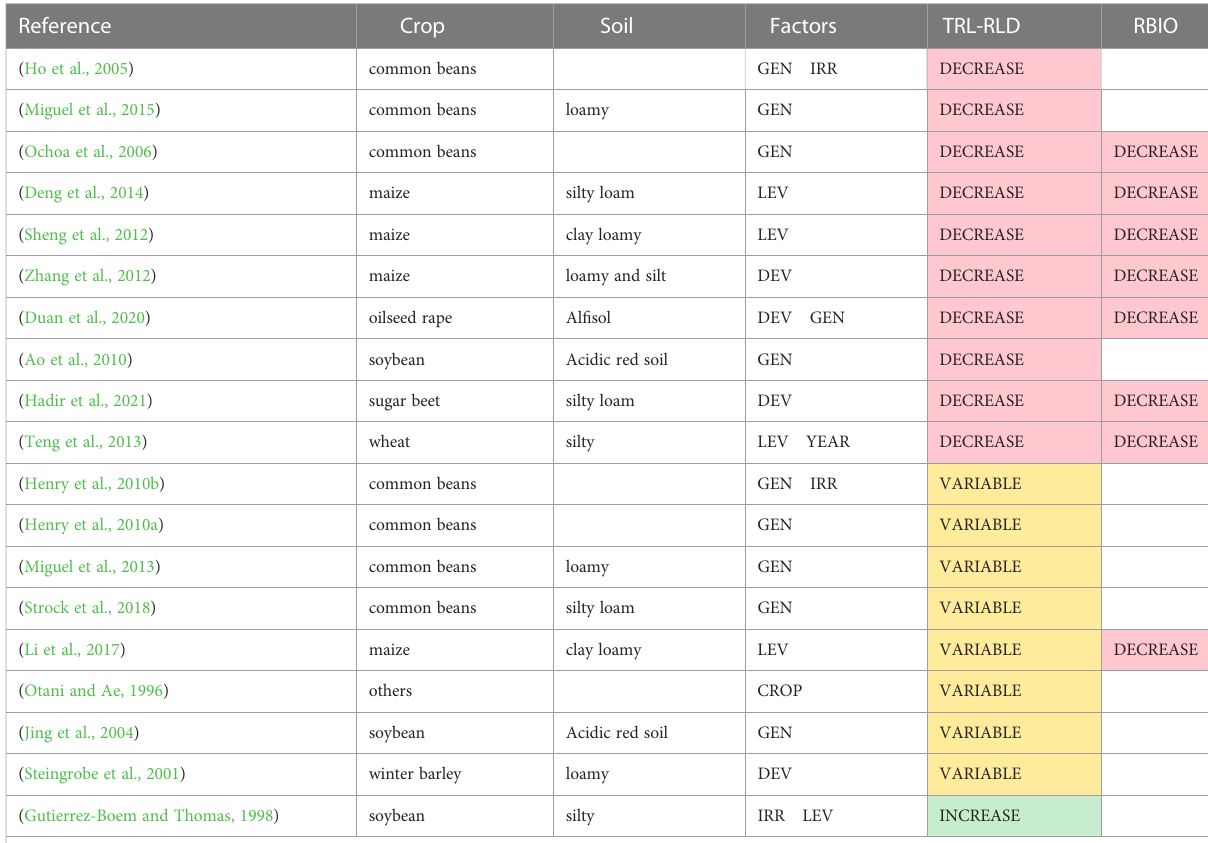
TABLE 6 Studies that report effects of P de fi ciency on total root length and/or root length density (TRL-RLD) and root biomass (RBIO) at fi eld